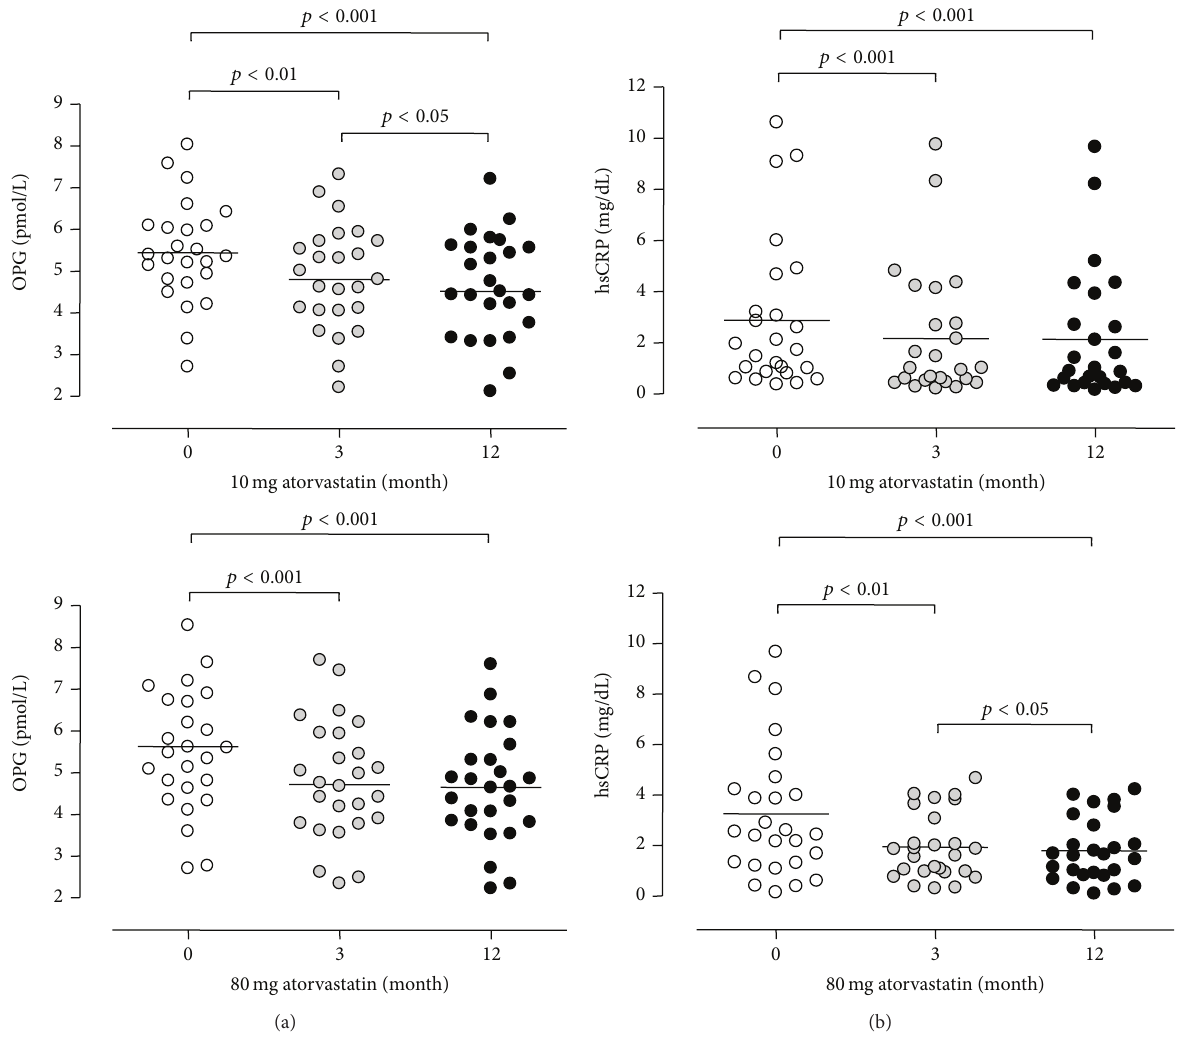
Figure 2: Reduction in OPG (a) and hsCRP (b) in 10 and 80mg groups at 3 and 12 months. OPG: osteoprotegerin; hsCRP: high-sensitivity c-reactive